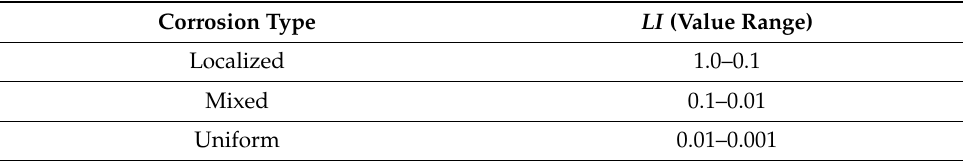
Table 3. Correlation between LI and type of corrosion expected [60].